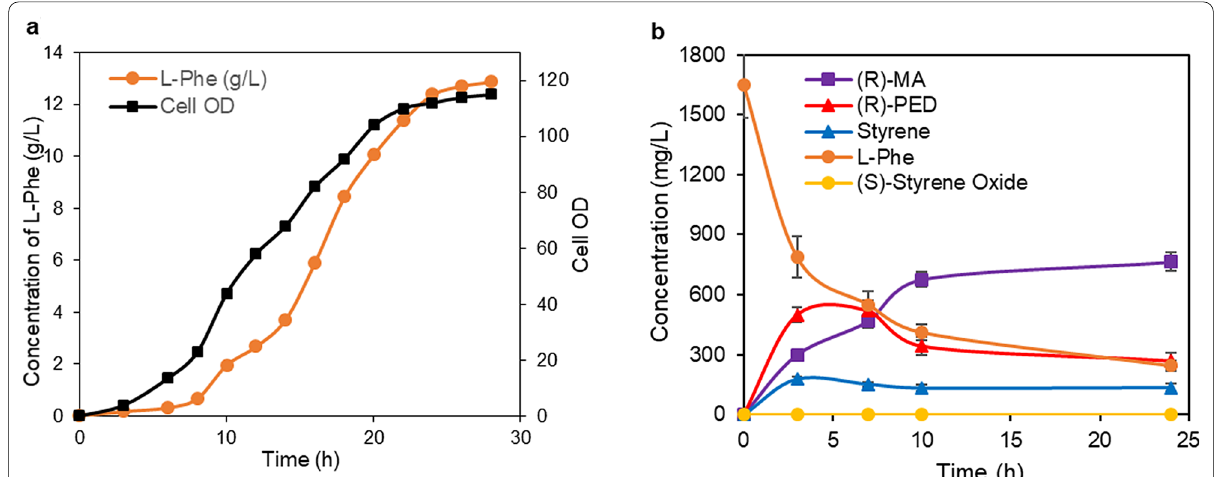
Fig. 4 Time course of producing ( R )-MA from glycerol via coupled E. coli (NST74-Phe) and E. coli (P2S2A). a Fermentative production of L -Phe from glycerol with E. coli (NST74-Phe). b Biotransformation of L- Phe to ( R )-MA by adding E. coli (P2S2A) cells into glycerol-fermented media of E. coli